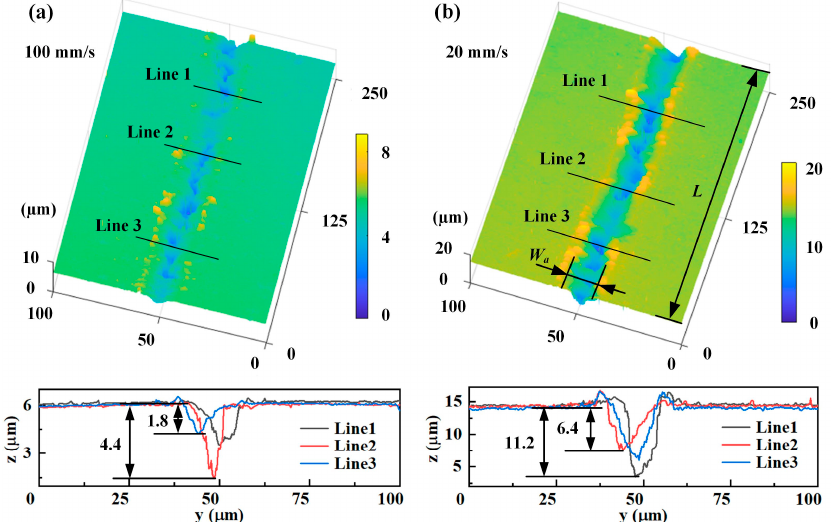
Figure 9. Three-dimensional confocal images and cross-sections of microgrooves at different scanning speeds: ( a ) 100 mm/s and ( b ) 20 mm/s.